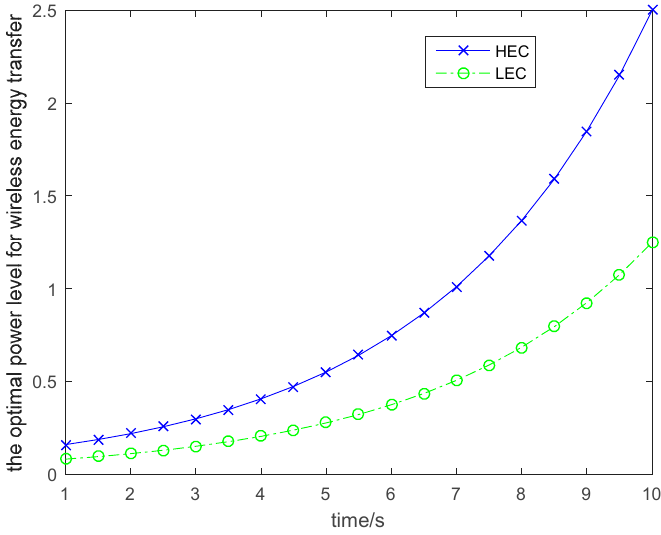
Figure 3. Power level for wireless energy transfer.